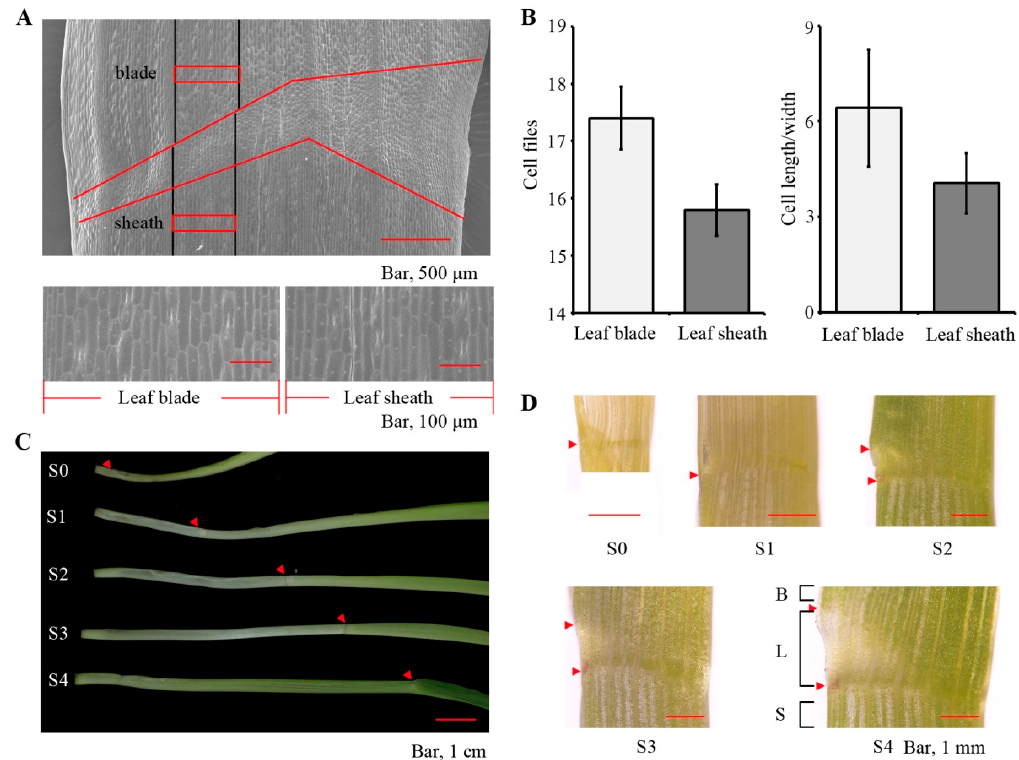
Figure 1. Observation of the leaf sheath and blade tissues. ( A ) Scanning electron micrograph of a mature maize leaf. B73 seedlings were grown for 13 days (stage 4). The red line indicates the ligular region, the tissues above the line are the blade and the tissues below the line are sheath tissues. The black line indicates the veins across the sheath, ligule and blade tissues of maize. ( B ) Cell file numbers and the ratio between the cell length and width were calculated in the leaf blade and sheath tissue between two lateral veins. ( C ) The blade and sheath tissues above or below the ligule of the third leaf from seedlings 10 (stage 1), 11 (stage 2), 12 (stage 3) and 13 (stage 4) days after planting were harvested at the same time. The arrowheads point to the leaf ligule. ( D ) Microscopic view of the blade (B), ligule (L) and sheath tissues (S) from stage 0 to stage 4 plants. The arrowheads point to the leaf ligule.